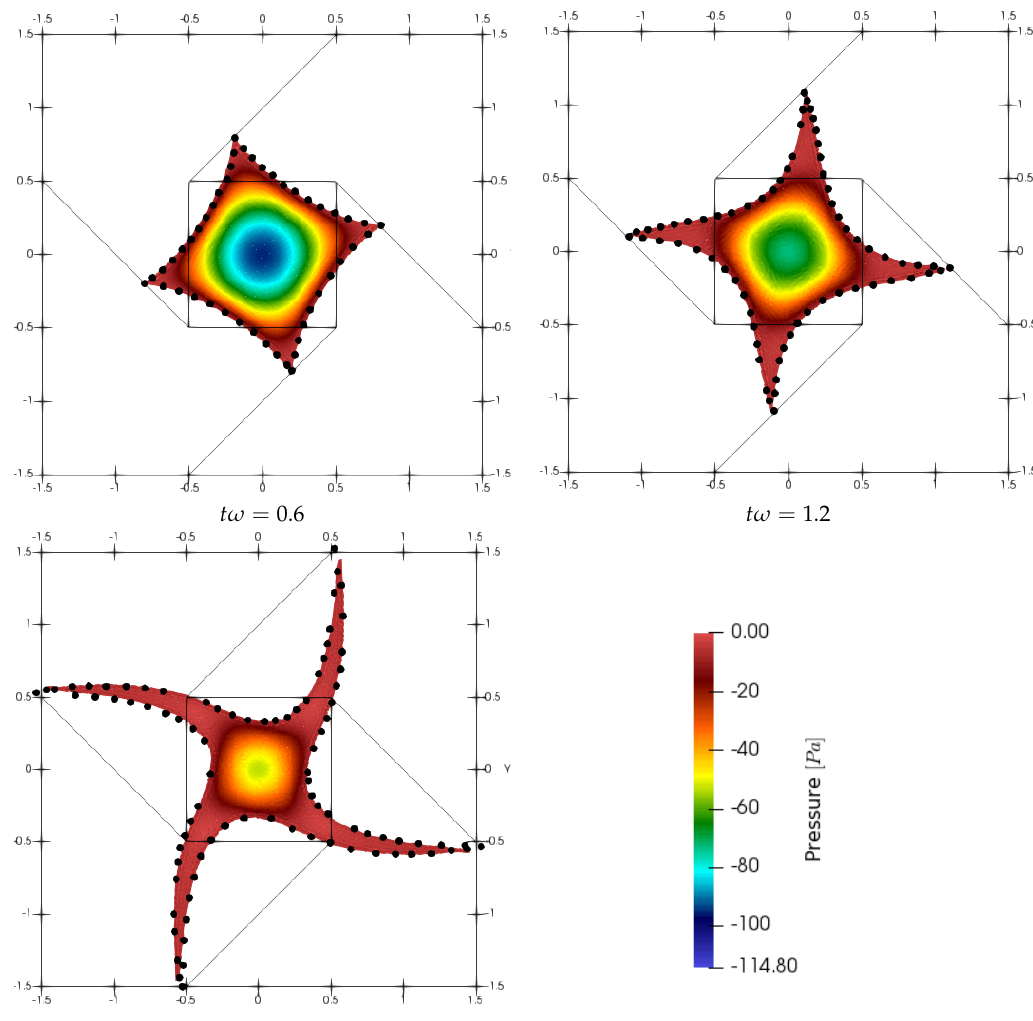
Figure 15. Evolution of an initially-square fluid patch: Pressure field obtained at dimentionless times t ω = { 0.6,1.2,2.04 } . The black bold points present the free surface evaluated by the Lagrangian Finite Difference Method